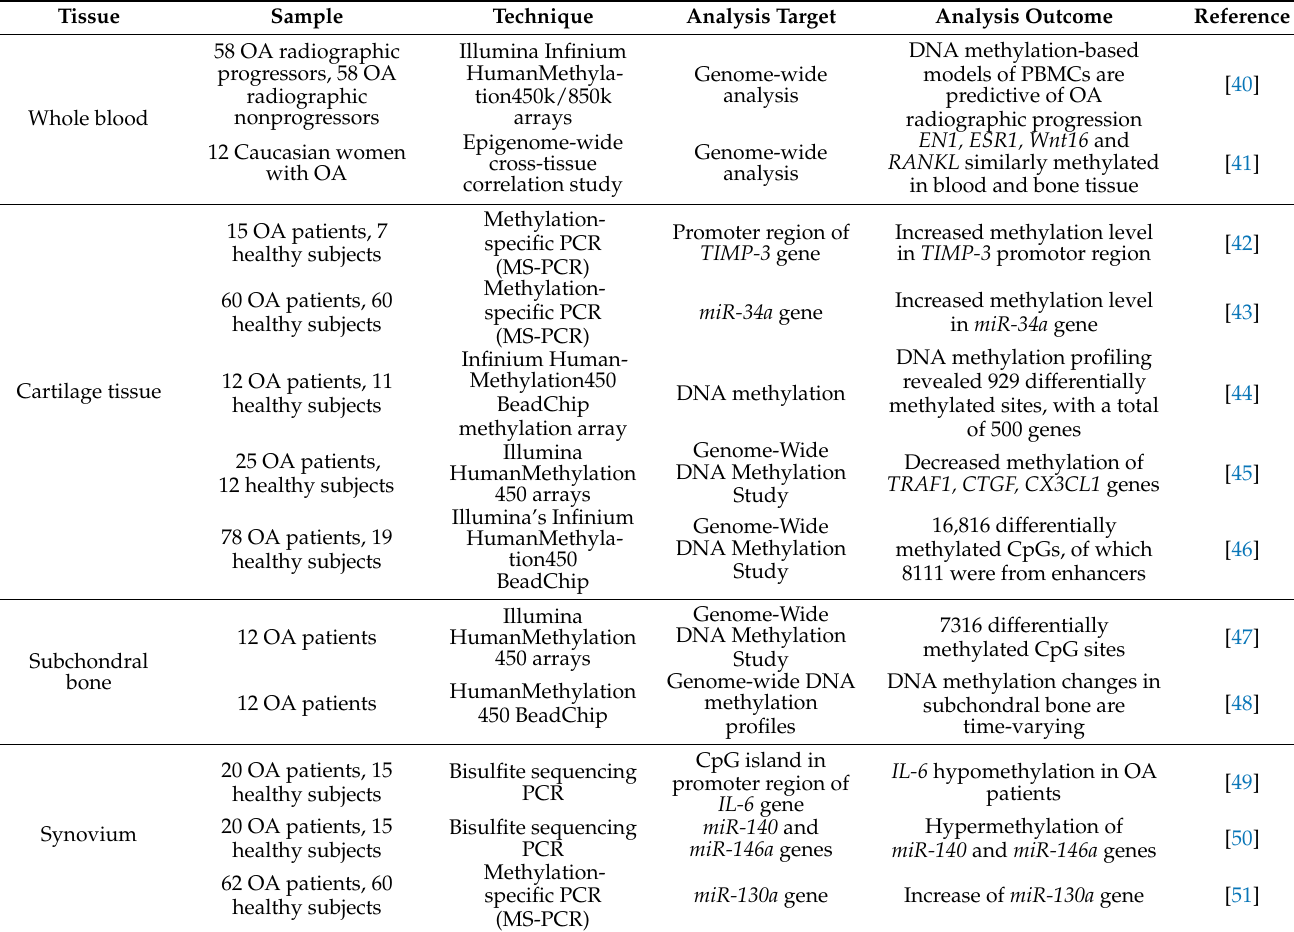
Table 2. Summary of DNA Methylation Studies in